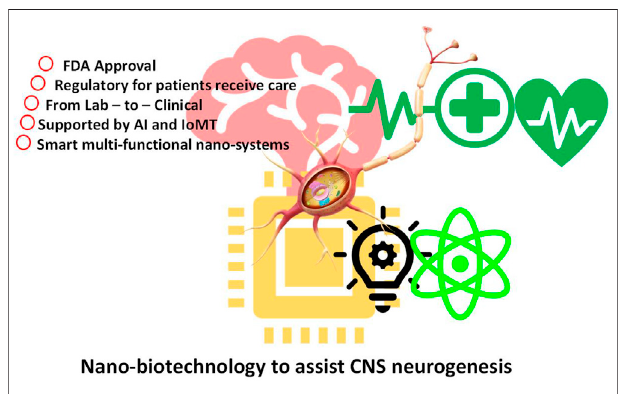
FIGURE 3 | Schematic presentation of strategies and steps by which nanobiotechnology assists CNS